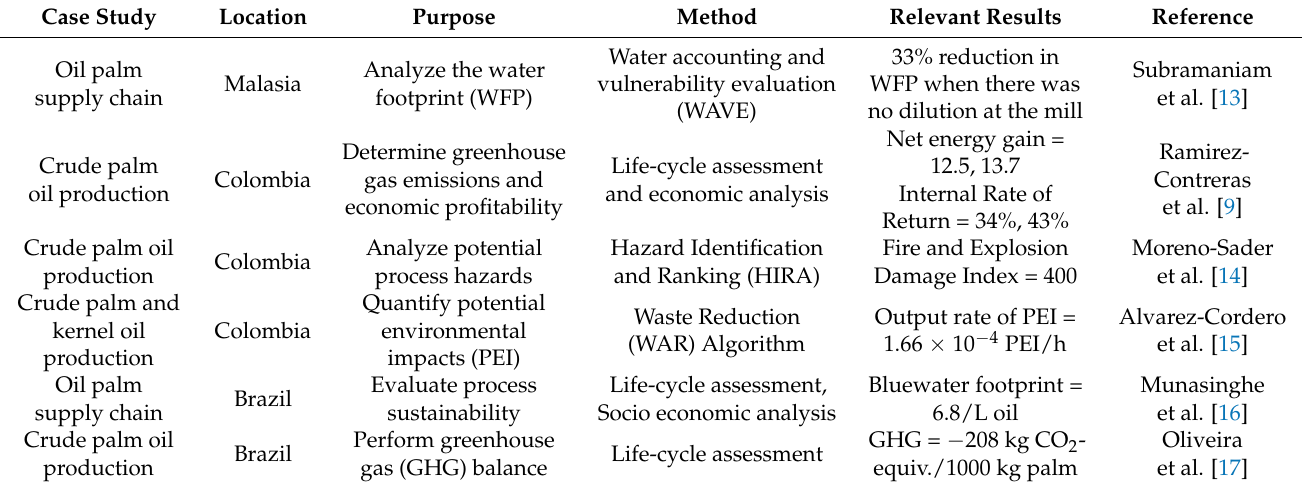
Table 1. Recent works addressing bioenergy systems in the oil palm